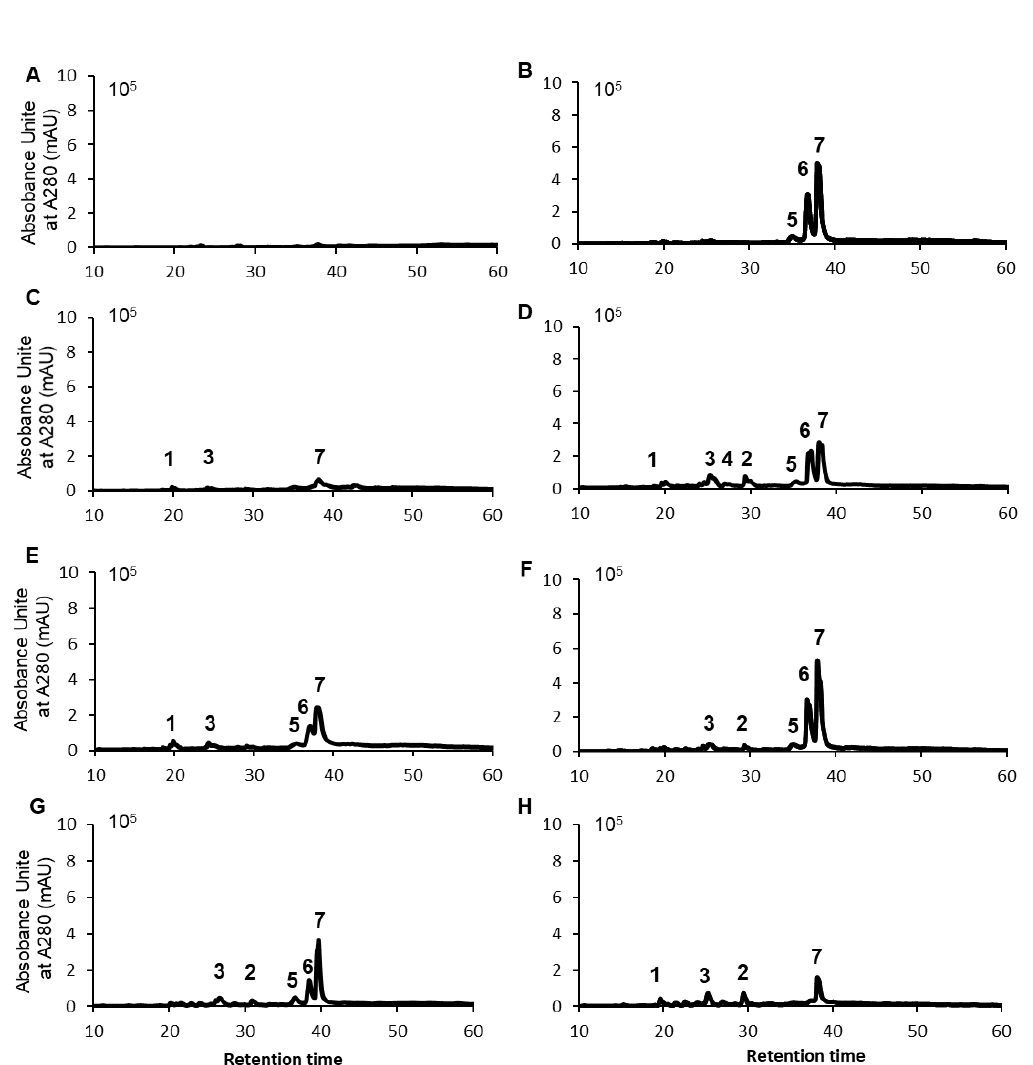
Figure 5. HPLC chromatograms of leaf extracts obtained from raspberry plants cultivated under condition A to H . Peak numbers are: 1 : (+)-catechin; 2 : (–)-epicatechin; 3 : procyanidin B4; 4 : flavan-3-ol trimer; 5 : 1-galloylpedunculagin; 6 : sanguiin H-6; and 7 : lambertianin C. The structure of each compound is shown in Figure 4. Table 2. Flavan-3-ol derivatives (mg/100 mg of DW) in raspberry leaf extracts.